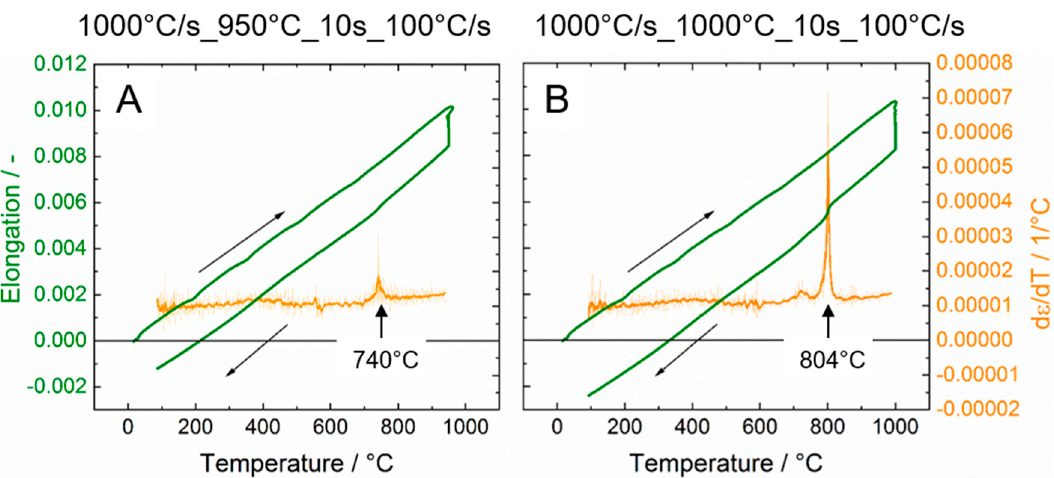
Figure 5. Comparison between elongation-temperature- and d ε / dT-distributions for 950 ◦ C ( A ) and 1000 ◦ C ( B ). In both experiments heating was carried out with 1000 ◦ C / s and cooling down at 100 ◦ C / s, respectively, while a holding time of 10 s was applied.